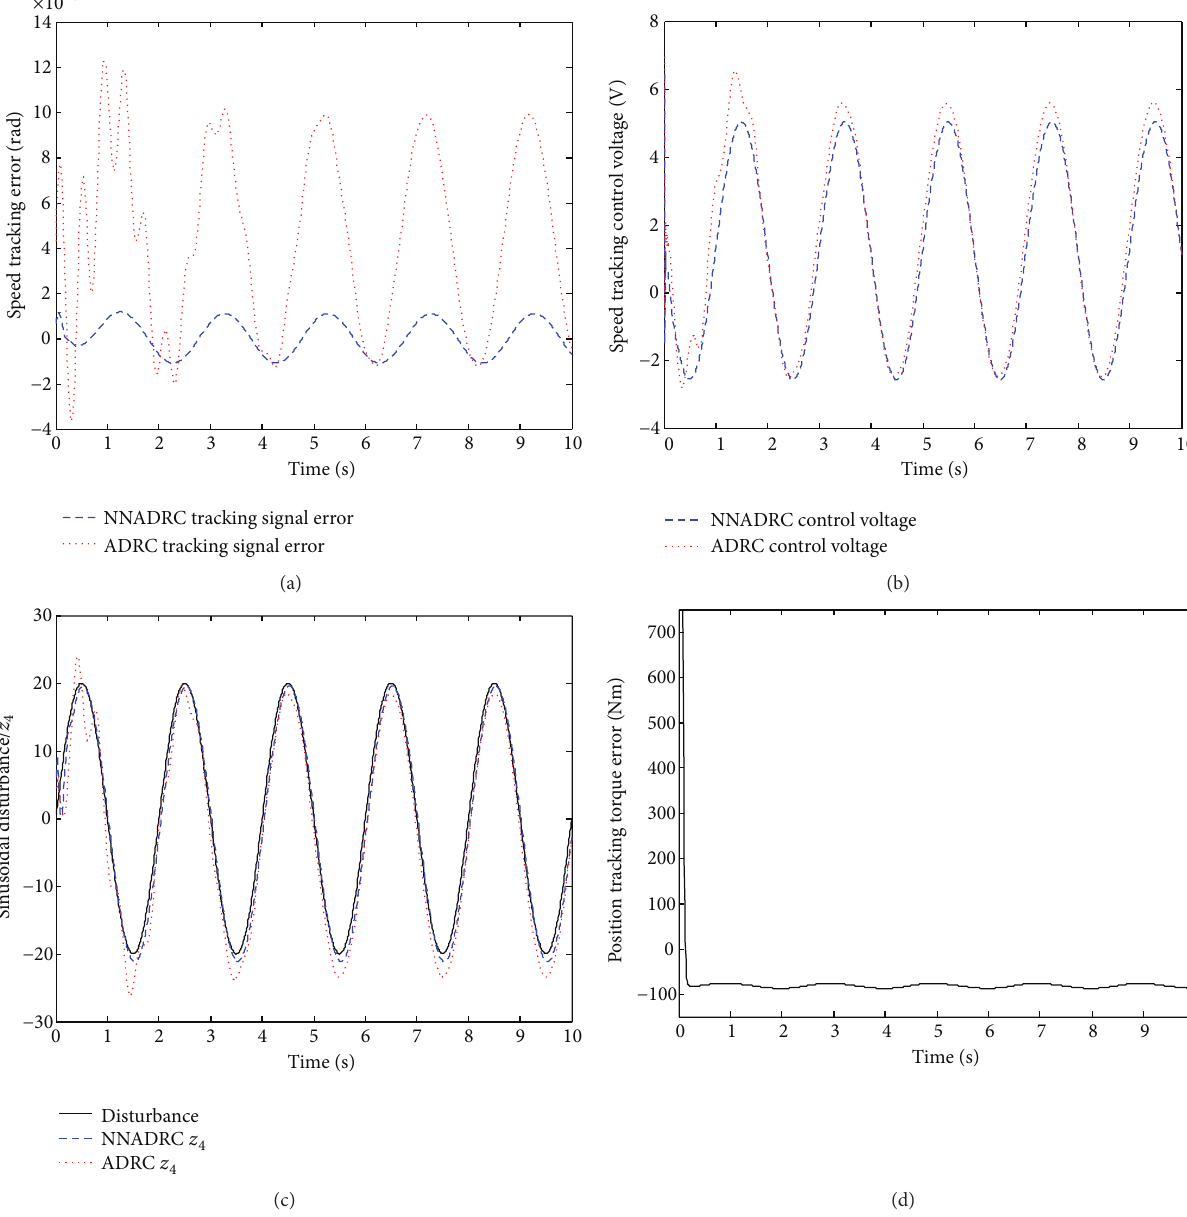
Figure 6: Response of the control system with constant speed tracking. (a) Errors of speed signal with sinusoidal disturbance, (b) speed tracking control voltage, (c) sinusoidal disturbance and the estimated z 4 , and (d) torque errors of speed